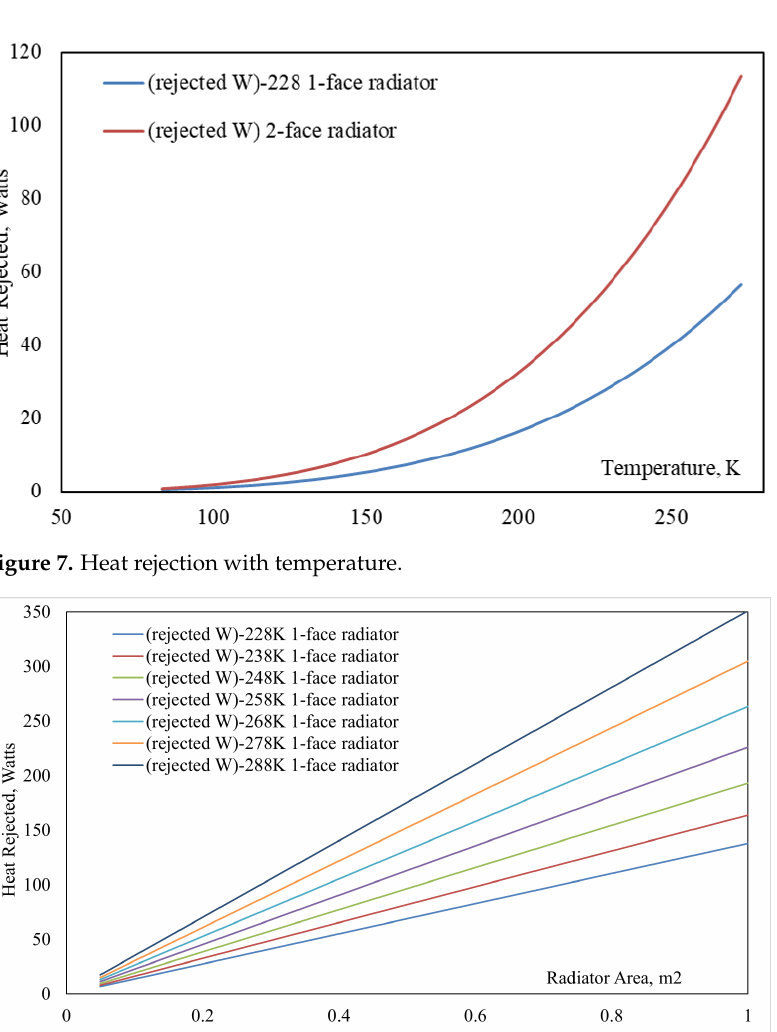
Figure 8. Heat rejection capacity with surface